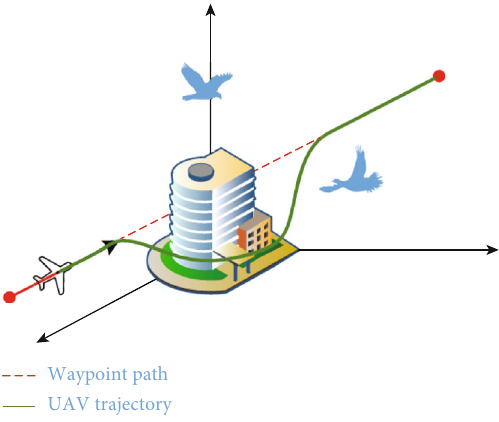
Figure 1: Obstacle avoidance